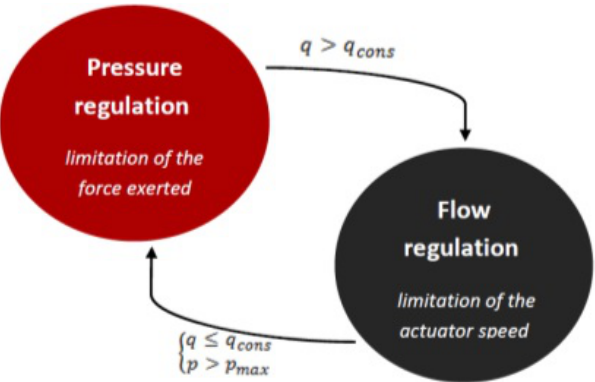
Figure 6. Regulation